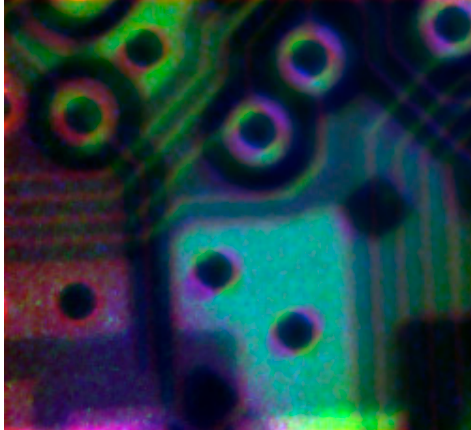
𝑇𝑛𝑜𝑟𝑚 , the green channel contains , the green channel T 𝑝𝑟𝑜𝑗 . K α 𝛼